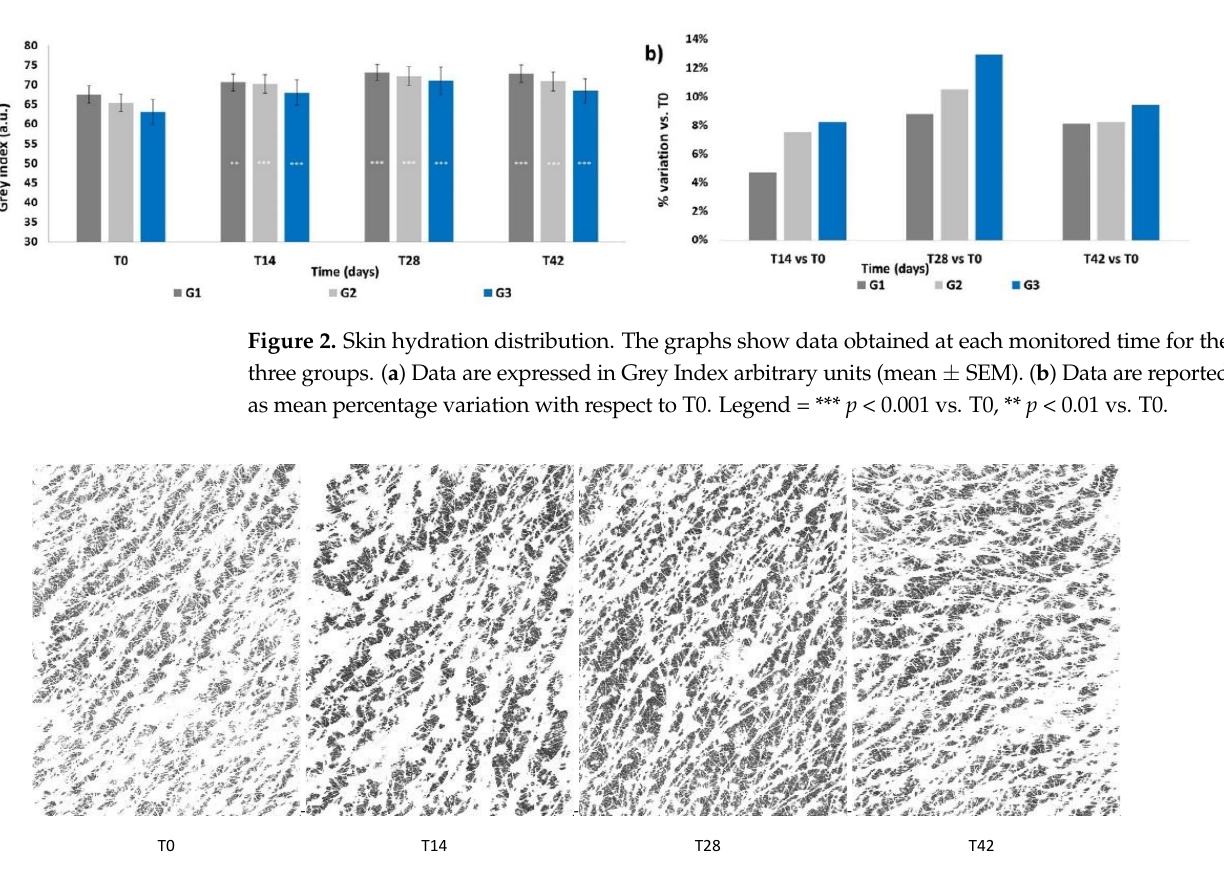
Figure 3. Moisturization Map images of a G3 subject throughout the study period.